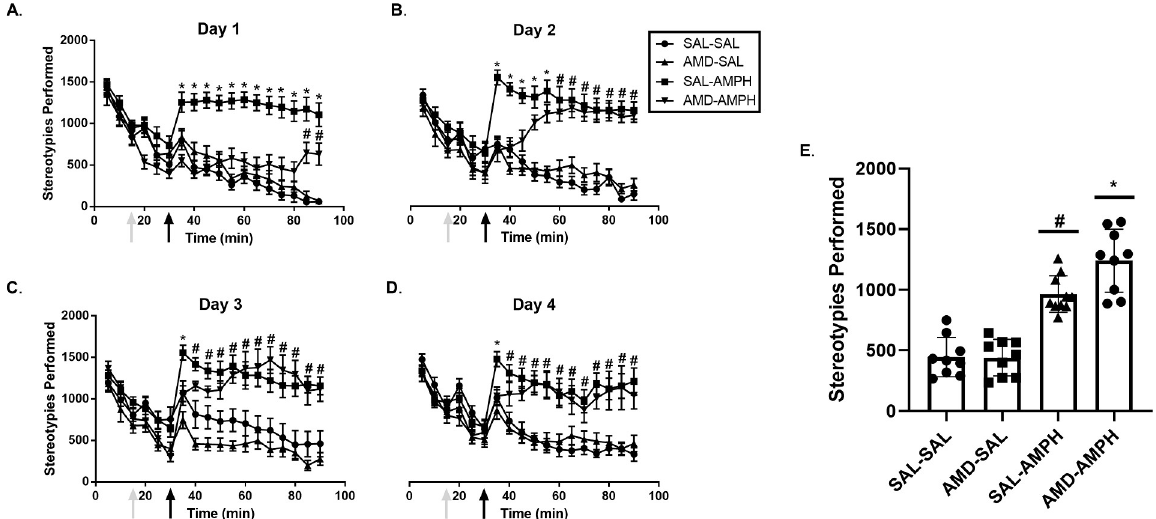
Fig 4. Average stereotypies performed following pretreatment and treatment conditions over the four-day period. Average stereotypies over the 4-day period following Pretreatment (AMD or SAL, grey arrows at time point 15 min) and Treatment (SAL or AMPH, black arrows at time point 30 min) conditions on (A) Day 1, (B) Day 2, (C) Day 3, and (D) Day 4. After observing main and interaction effects, post-hoc analyses identified significant pairwise groups differences. Asterisks ( � ) represent significant differences between the SAL-AMPH relative to all other groups. Hash marks (#) represent significant differences between the AMD-AMPH and all other groups. (E) The data are represented as a scatterplot of the cumulative average of stereotypies completed by each group over the four days of testing (Mean ± SEM).